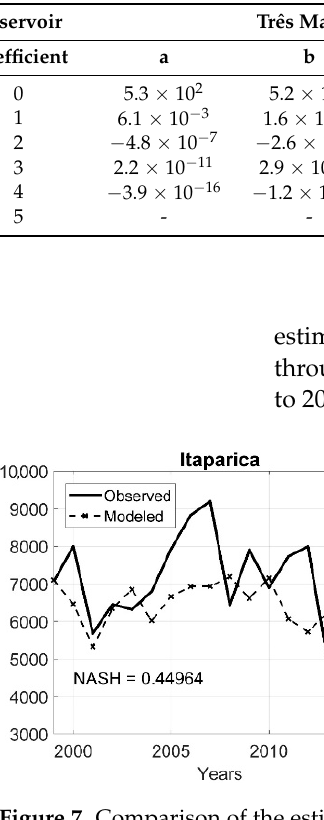
Figure 7. Comparison of the estimates of the annual energy production by the ( a ) Itaparica, ( b ) Sobradinho and ( c ) Três Marias hydroelectric power plants for the period 1999 to 2016 with the SIGA software.